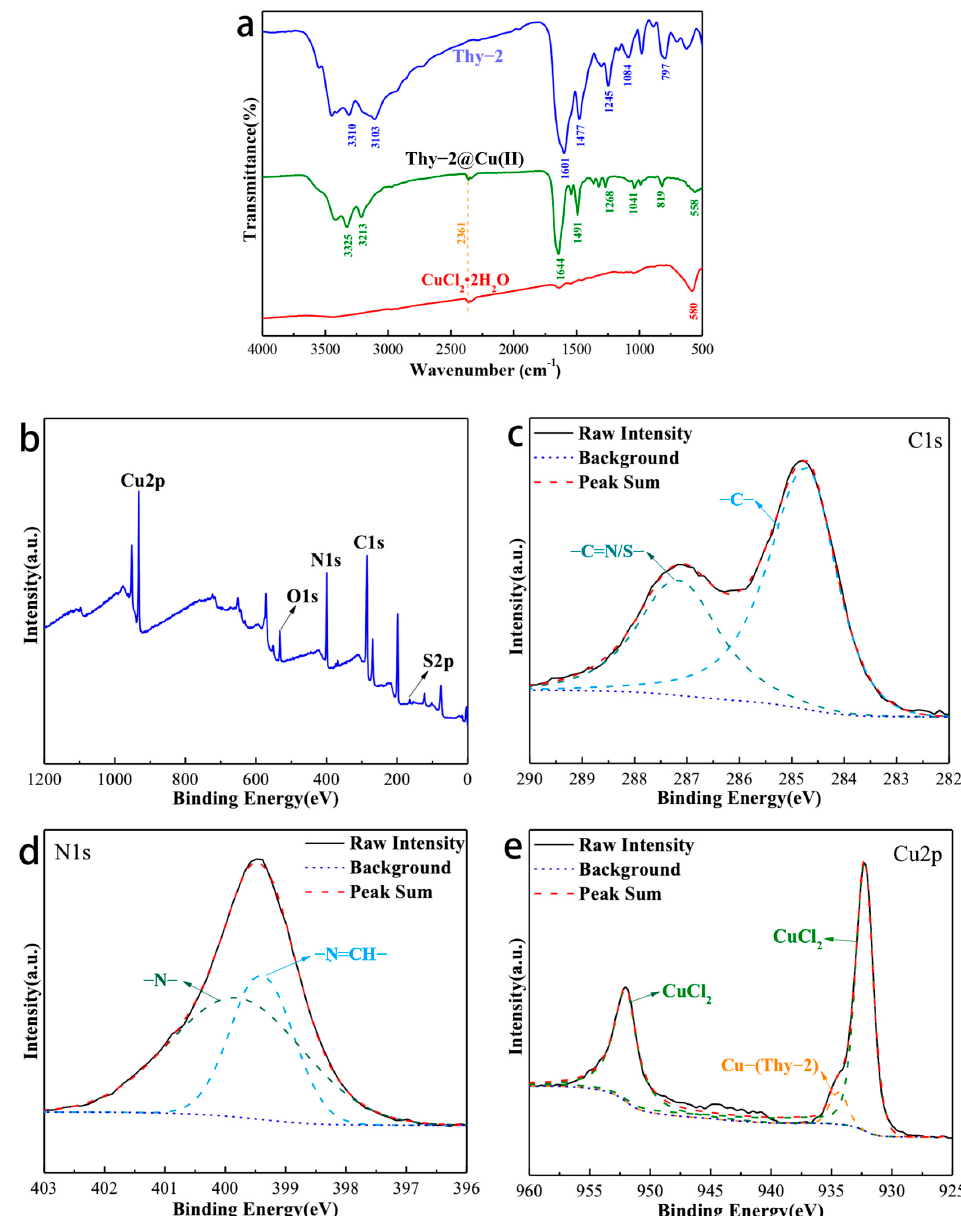
Figure 4. ( a ) Infrared spectrum of Thy-2, Cu(II)@Thy-2 and CuCl2·2H 2 O; ( b ) XPS spectrum of Cu(II)@Thy-2 inhibitor; ( c ) Survey scan spectra; ( d ) Narrow scan spectra of C1s; ( e ) N1s; d) Cu2p. According to the previous experimental data analysis results, the anodic metal dis- solution reaction and cathodic hydrogen precipitation reaction are inhibited to varying degrees by the addition of Cu(II)@Thy-2 compound corrosion inhibitor, with the anodic reaction being inhibited to a greater extent and resulting in a signi fi cant increase in β a before and after the addition of the corrosion inhibitor. As such, the corrosion inhibitor is the primary anodic protection of the hybrid. We can accurately predict the corrosion rate of metals by extrapolating the cathodic polarization curve’s slope [30]. When the corrosion